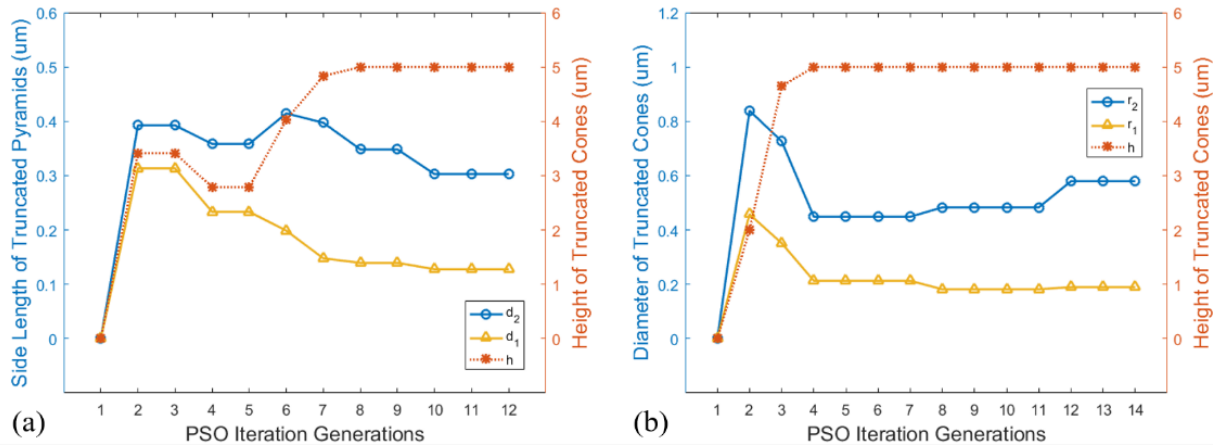
Figure 3. Updating trends of the structural parameters in ( a ) the TPA and ( b ) the